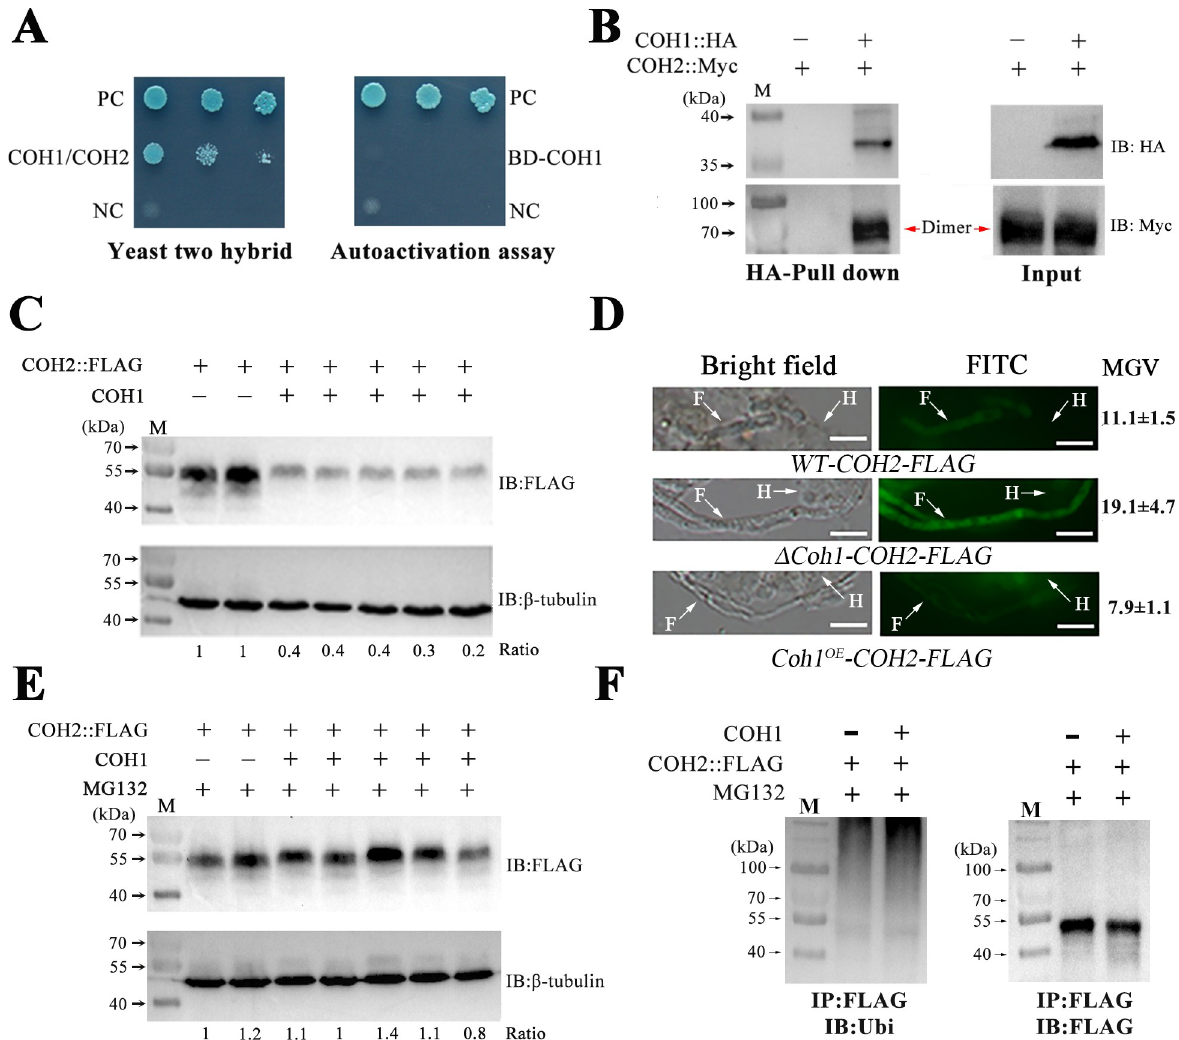
Fig 3. COH1 physically interacts with the transcription factor COH2 to reduce COH2 stability. (A) Yeast 2-hybrid analysis confirms the physical interaction of COH1 with COH2. Left panel: colonies were grown in SD/ − Ade/ − His/ − Leu/ − Trp + X- α -gal + AbA AU : PleasecheckthattheSDmediumnamesinthelegendtoFig 3 arecorrect ð editedtomatchtheformatontheTakaraBiowebsite Þ : . Right panel: COH1 lacks autoactivation activity. The Y2HGold cells with pGBKT7-COH1 cannot grow in SD/ − Ade/ − His/ − Trp + X- α -gal. BD, binding domain; AU : IdefinedtheabbrevationBDinFig 3 asbindingdomain : Ifthisisnotcorrect ; pleaseeditFig 3 legendtoprovidecorrectdefinition : NC, negative control (yeast cells containing the plasmid pGADT7-T and pGBKT7-Lam); PC, positive control (yeast cells containing the plasmid pGADT7-T and pGBKT7-53). (B) Coimmunoprecipitation confirmation of the physical interaction of COH1 with COH2. The fusion proteins COH1::HA and COH2::Myc (molecular weight = 44.6 kDa) were simultaneously expressed in the strain COH1-HA/COH2-Myc . The control was the strain WT-COH2-Myc expressing the protein COH2::Myc. Immunoprecipitation was conducted with anti-HA antibody. Proteins were detected by immunoblot (IB) analysis with anti-HA or anti-Myc antibodies. The dimer COH2::Myc is indicated by red arrows. M, protein ladder. AU : IdefinedtheabbrevationMinFig 3 asDNAladder ð perFig 1 Þ : Ifthisisnotcorrect ; pleaseeditFig 3 legendtoprovidecorrectdefinition : (C) Differential accumulation of the COH2::FLAG protein in 2 isolates of the strain WT-COH2-FLAG and 5 isolates of the strain Coh1 OE -COH2-FLAG . Equal loading of proteins was confirmed by the β -tubulin protein that was detected by the anti- β -tubulin antibody. Numbers indicate band intensity for COH2::FLAG relative to β -tubulin. The values of the #1 isolate of the strain WT-COH2-FLAG were set to 1. (D) Histoimmunochemical staining of the COH2::FLAG protein in fungal cells in the real hemocoel of G . mellonella larvae. Top panel: the strain WT-COH2-FLAG ; middle panel: Δ Coh1-COH2-FLAG ; bottom panel: Coh1 OE -COH2-FLAG . Scale bar represents 10 μ m. Images are representative of 3 independent experiments. F, fungal cells; FITC, fluorescein isothiocyanate; H, hemocyte; MGV, mean gray value. (E) Confirmation of degradation of the COH2::FLAG protein by the proteasome pathway. The mycelium grown in Sabouraud dextrose broth supplemented with 1% yeast extract (SDY) medium was treated with the 26S proteasome inhibitor MG132. (F) The ubiquitination level of the COH2::FLAG protein increased due to its interaction with COH1. The COH2::FLAG protein was pulled down from the MG132-treated mycelium with an anti-FLAG antibody and immunoblotted with an anti-ubiquitin (Ubi) antibody (left) and the anti-FLAG antibody (right). IP, immunoprecipitation.